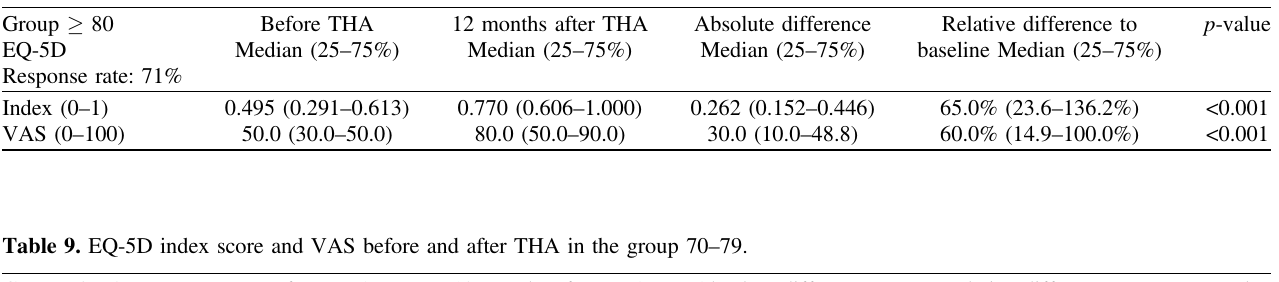
Table 8. EQ-5D index score and VAS before and after THA in the group (cid:3) 80.